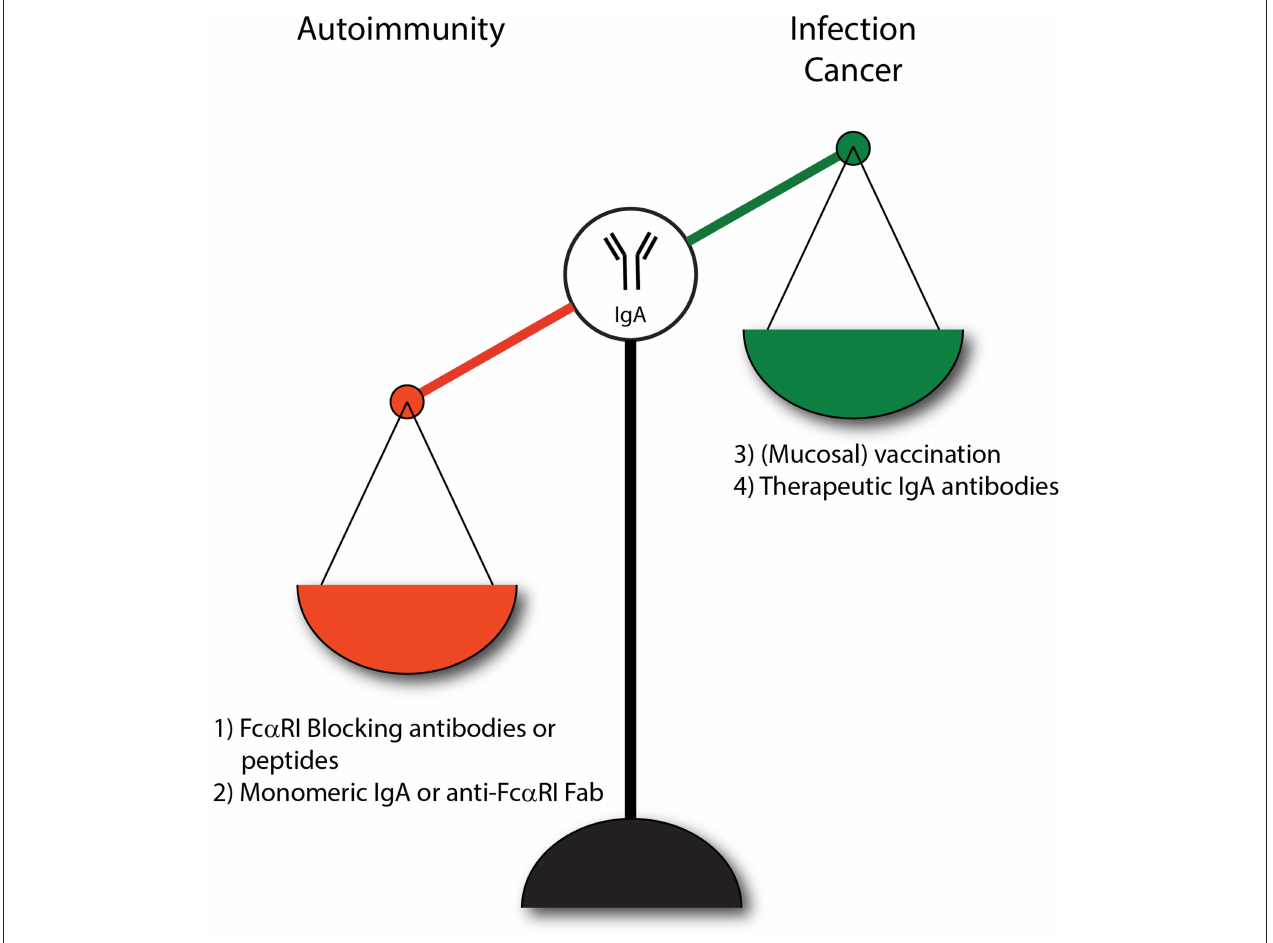
FIGURE 4 | IgA and Fc α RI as therapeutic targets. (1) Enhanced IgA-Fc α RI activation in IgA-associated autoimmune diseases is unwanted. Blocking IgA-Fc α RI interactions by monoclonal antibodies or peptides may reduce tissue damage in these diseases. (2) Treatment with monomeric IgA or anti-Fc α RI Fabs may induce ITAMi signaling thereby inhibiting IgG-induced phagocytosis and IgE-mediated allergic diseases. (3) To combat infections, administration of IgA (passive vaccination) or induction of IgA levels via active vaccination may result in enhanced protective immunity. (4) IgA monoclonal antibody therapy may result in efficient killing of tumor cells by activating Fc α RI-expressing immune